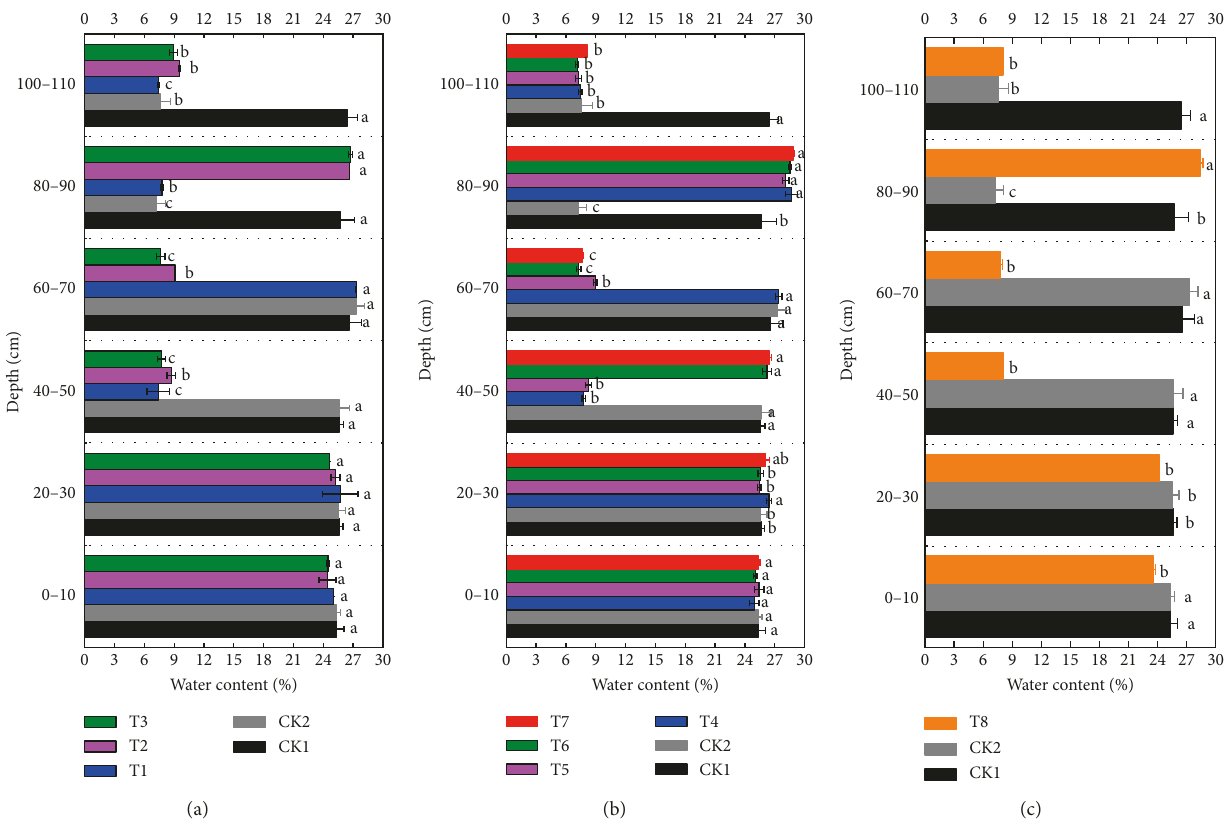
Figure 7: Soil water content of interlayered